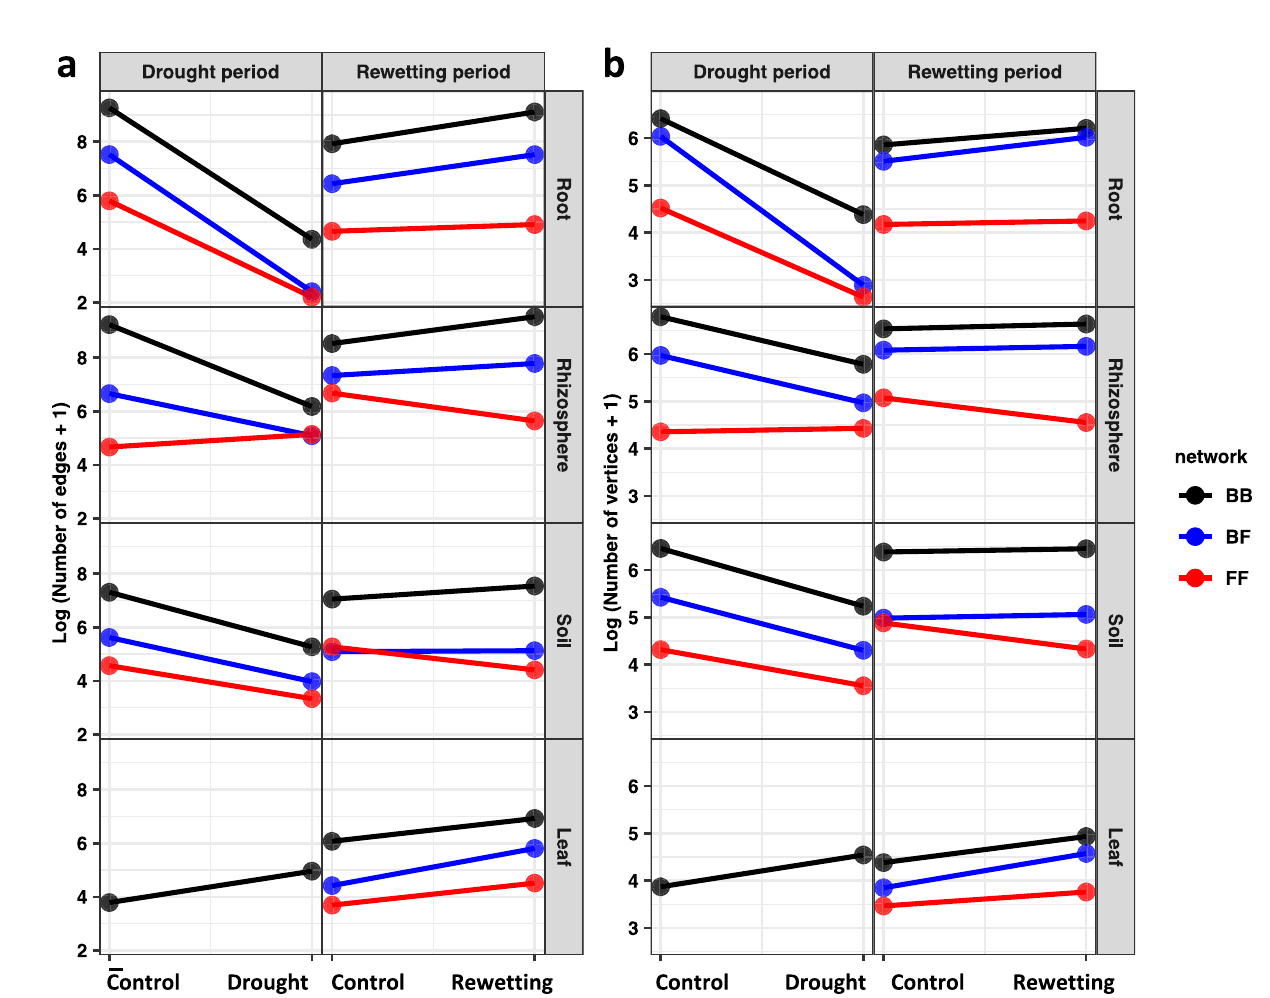
Fig. 4 Microbial co-occurrences in drought-stress and drought relief. The complexities of microbial co-occurrence networks are demonstrated by a the number of vertices and b the number of edges. All three types of co-occurrences (fungus-fungus, FF, red; bacterium-bacterium, BB, black; and bacterium- fungus, BF, blue) are generally disrupted by drought (but not FF in rhizosphere and BB in leaf) and recovered by rewetting. Source data are provided as a Source Data fi